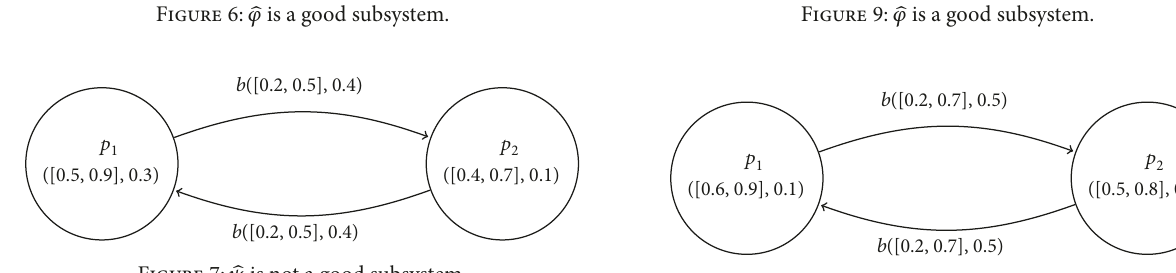
Figure 10: ̂𝜓 is not a good subsystem.